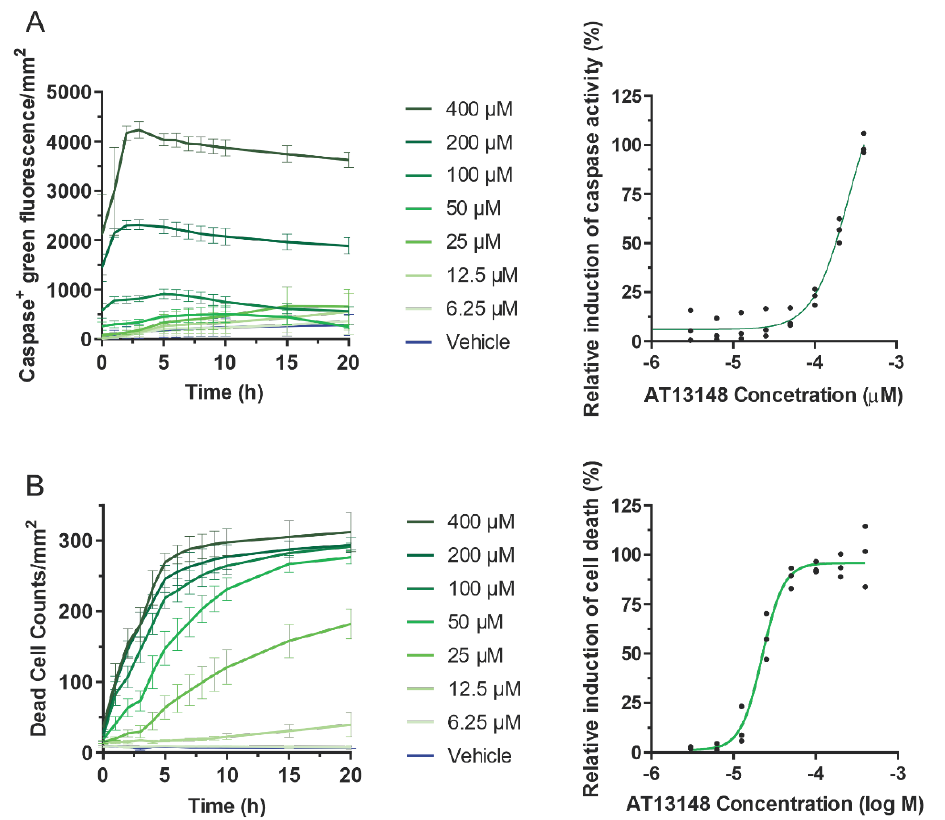
Figure 8. Primary hepatocyte apoptosis in response to AT13148 exposure. Time courses and dose responses of the numbers of ( A ) active caspase 3/7 positive and ( B ) dead hepatocytes to AT13148 concentrations ranging from 6.25–400 µ M, over time. Caspase 3/7 activation was assessed with CellEvent green and apoptotic hepatocyte numbers were assessed with Sytox Green. Data shown are averaged results from 3 independent experiments. For the dose response time course graphs (left panels), lines represent means ± SD. For EC 50 graphs (right panels), points represent normalized values from independent replicate experiments. Fitted lines were from non-linear regression fits with variable sloped to determine the EC 50